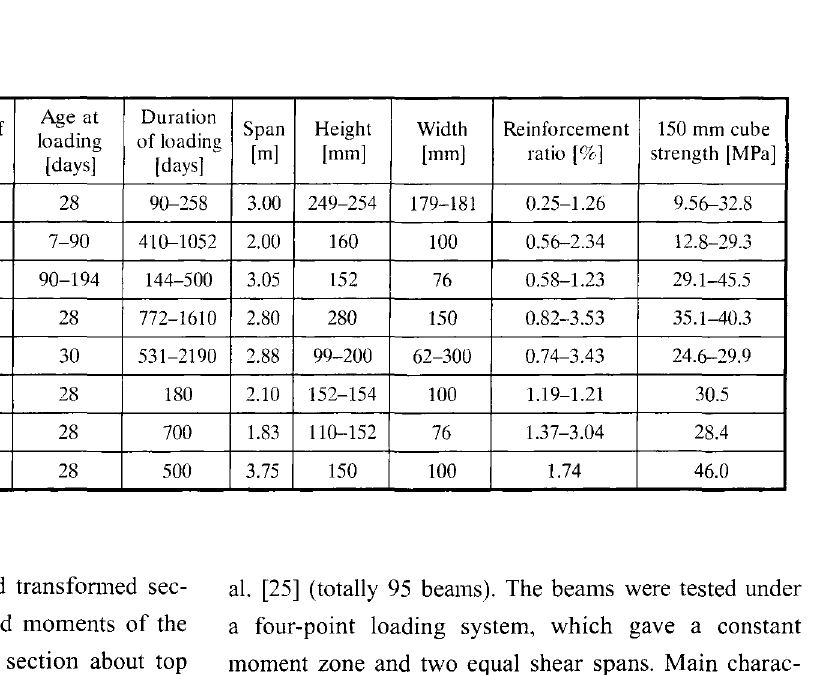
Table 1. Main characteristics of beams